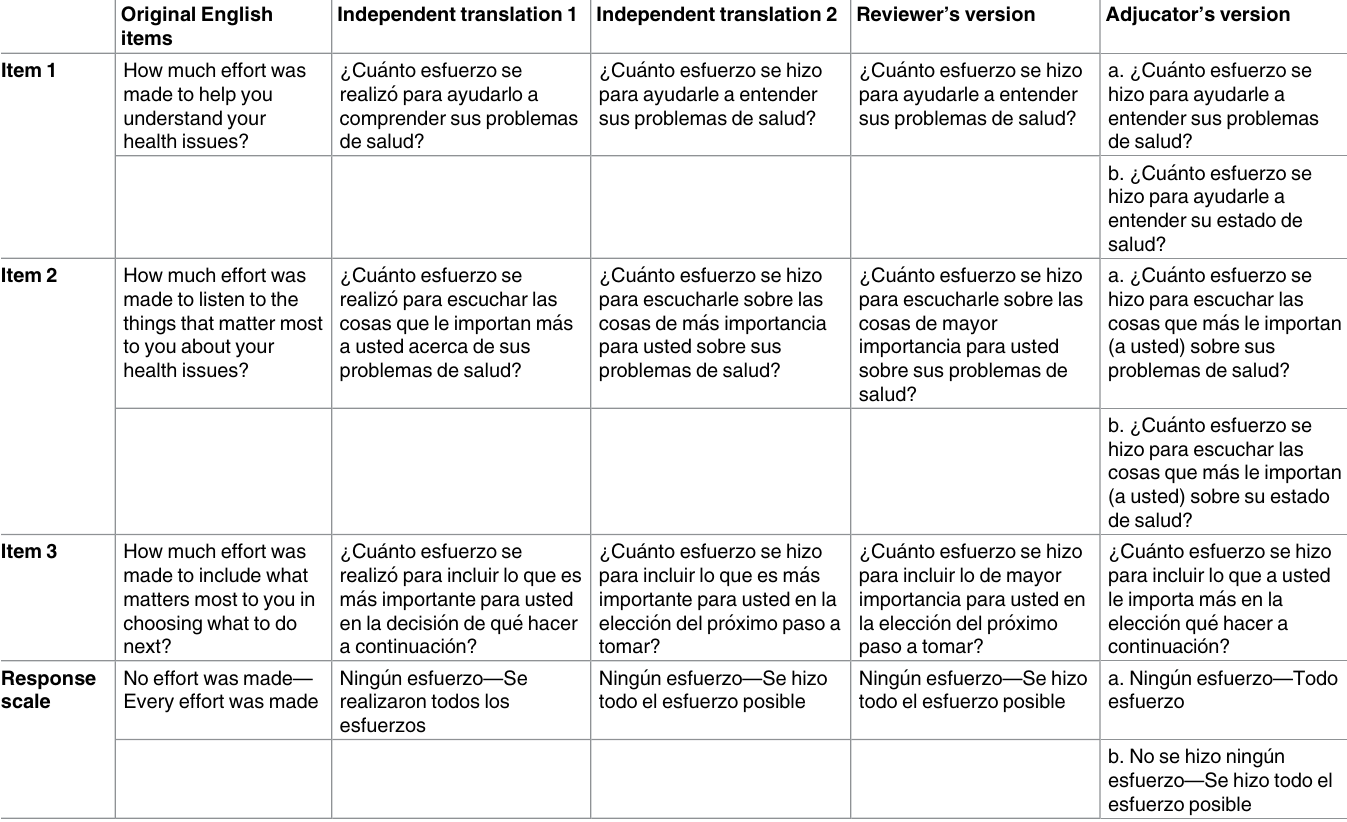
Table 1. Item progression: Translation